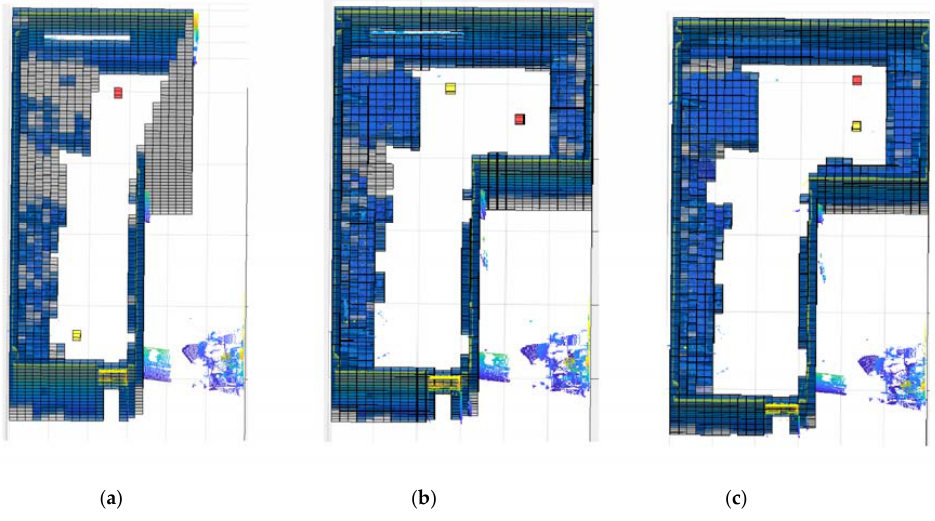
Figure 17. Occlusion evolution. Blue: occupied voxels; grey: occluded voxels; red: next best view (NBV) voxel; yellow: current scan position. ( a ) First scan. ( b ) Second scan. ( c ) Third scan.